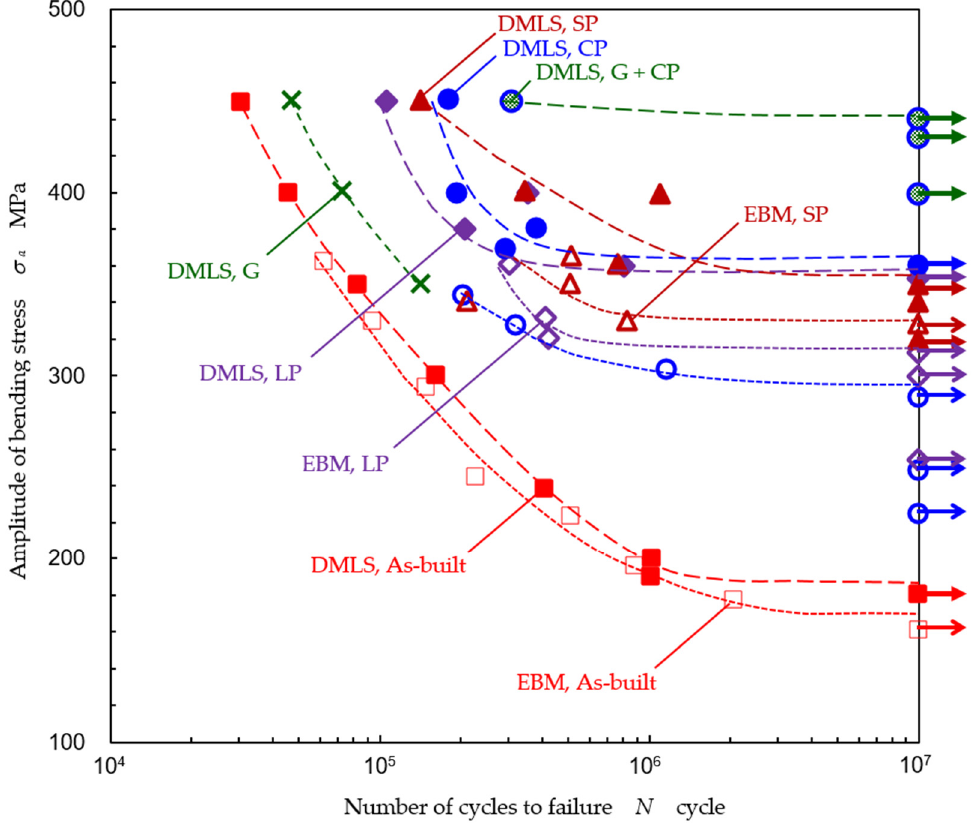
Figure 10. Improvement of the fatigue properties of Ti6Al4V manufactured by DMLS and EBM through cavitation peening (CP), laser peening (LP), shot peening (SP) grinding (G), and cavitation peening after grinding (G + CP), compared with the as-built specimen. Table 1. Fatigue strength and improvement ratio of the as-built Ti6Al4V manufactured by DMLS and EBM and the Ti6Al4V manufactured by DMLS and EBM through cavitation peening (CP), laser peening (LP), shot peeing (SP), grinding (G), and cavitation peening after grinding (G + CP).